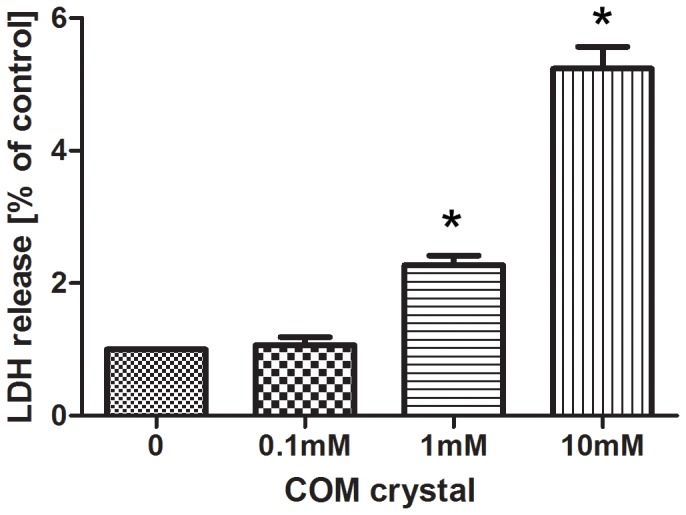
COM crystals increased LDH release from HK-2 cells.HK-2 cells were incubated with different concentrations (0, 0.1, 1, 10)mmol/L of COM for 24 h in triplicate samples to determine LDH activity released into media. Symbol (*) indicates significant difference from 0-control (P<0.05).